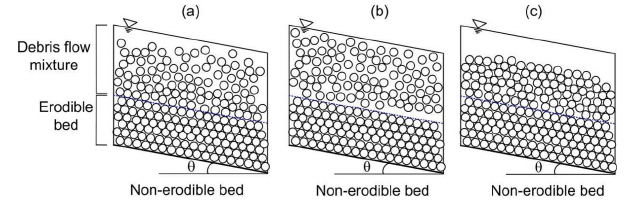
Figure 4. Three typical suspension scenarios: (a) partial suspen- sion, 0< C s <1; (b) full suspension, C s = 1; (c) no suspension, C s =